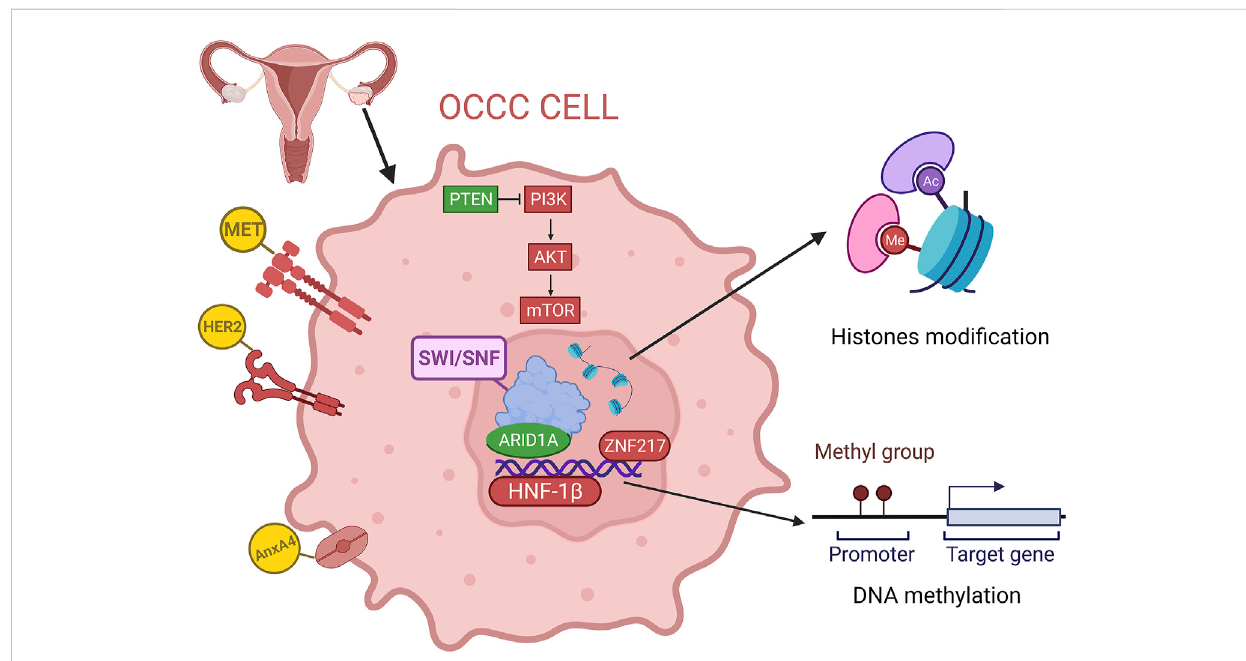
FIGURE 1 Overview ofthegenomics andepigeneticsofOCCC, includinggene mutation,copy numbervariations,DNAmethylationandhistone modi fi cation. (red for overexpression or ampli fi cation, green for